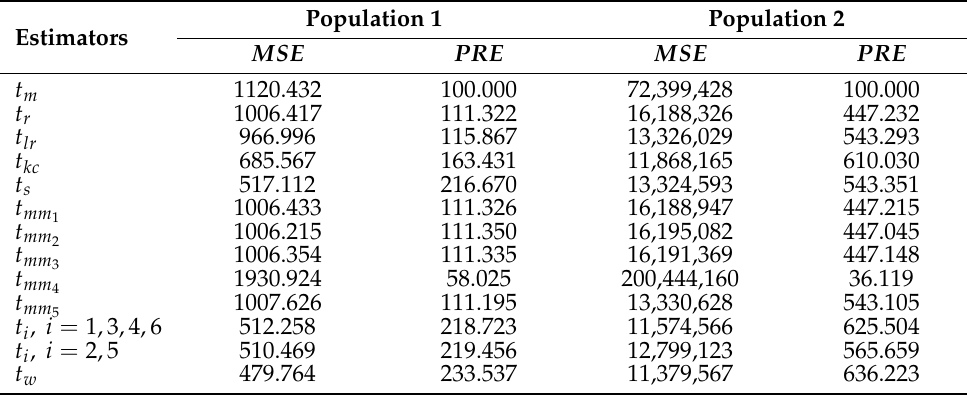
Table 2. MSE and PRE of estimators for natural populations.